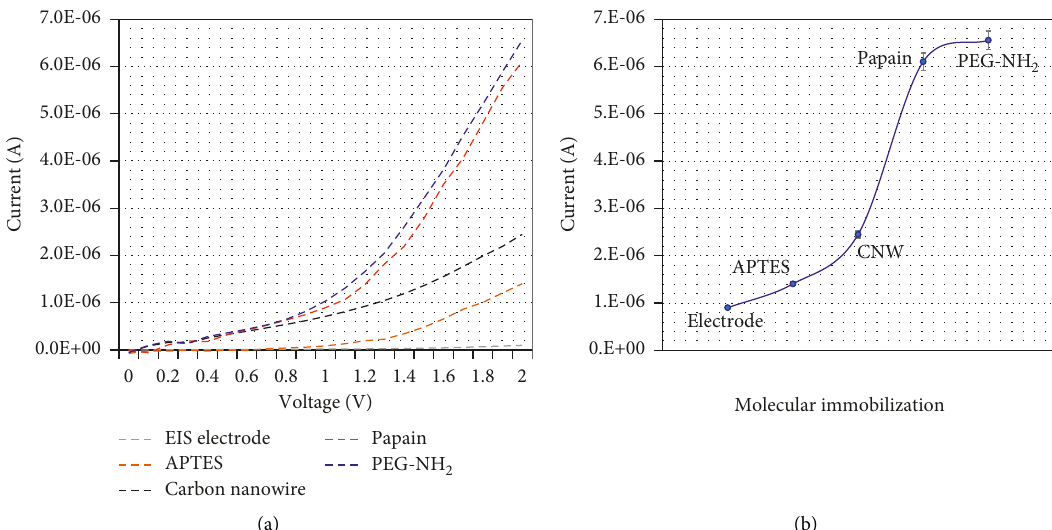
Figure 3: Process of the capture probe “papain” immobilization on the carbon nanofiber-modified interdigitated electrode surface. (a) Voltages vs current responses for the immobilization process. Clear increment of current was noted after each immobilization. (b) The current level of the capture probe “papain” immobilization process. A higher increment of current was recorded after adding papain on the electrode.